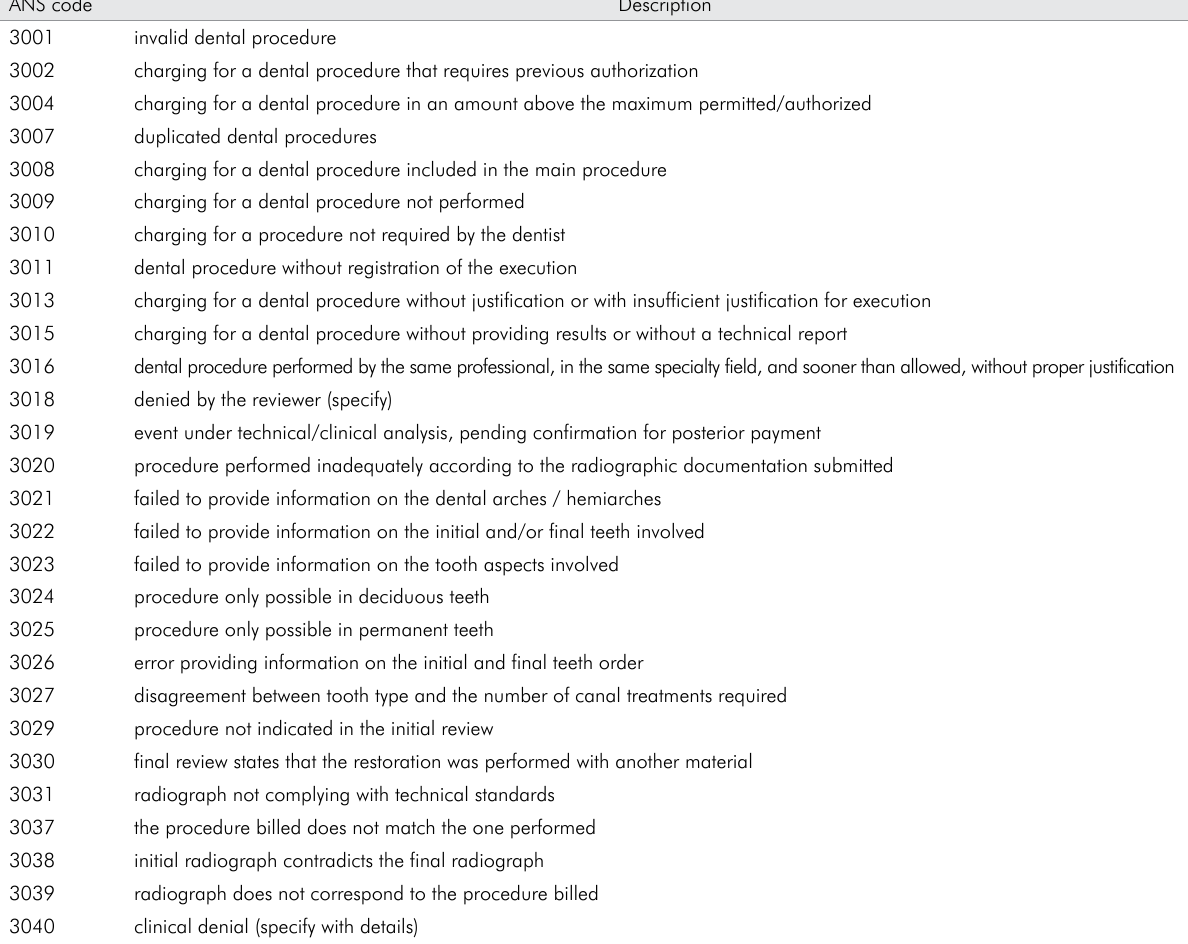
Table 1. Code and description of claims